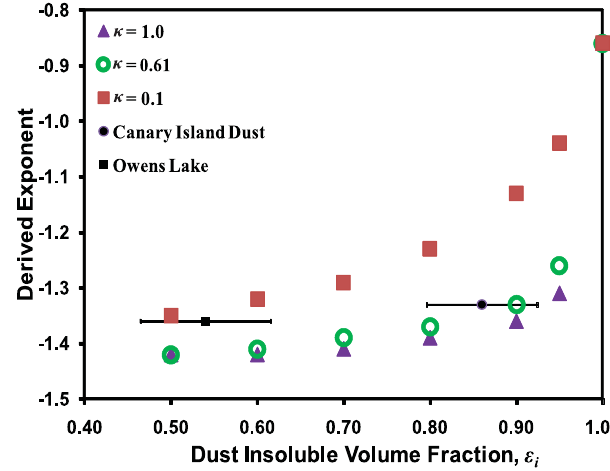
Fig. 9. Derived theoretical exponent as a function of ε i for differ- ent values of κ computed at A FHH = 2 . 25 and B FHH = 1 . 20. Also shown are data points for Canary Island Dust and Owens Lake dust (data obtained from Kumar et al.,